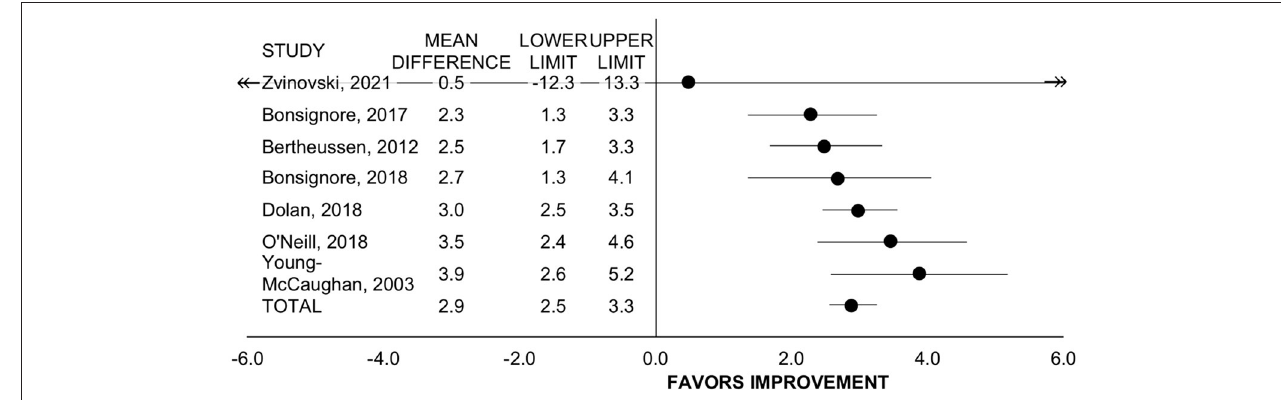
FIGURE 3 | Forest plot displaying mean difference and 95% CIs for the impact of rehabilitation on VO 2 peak (mL/kg/min).